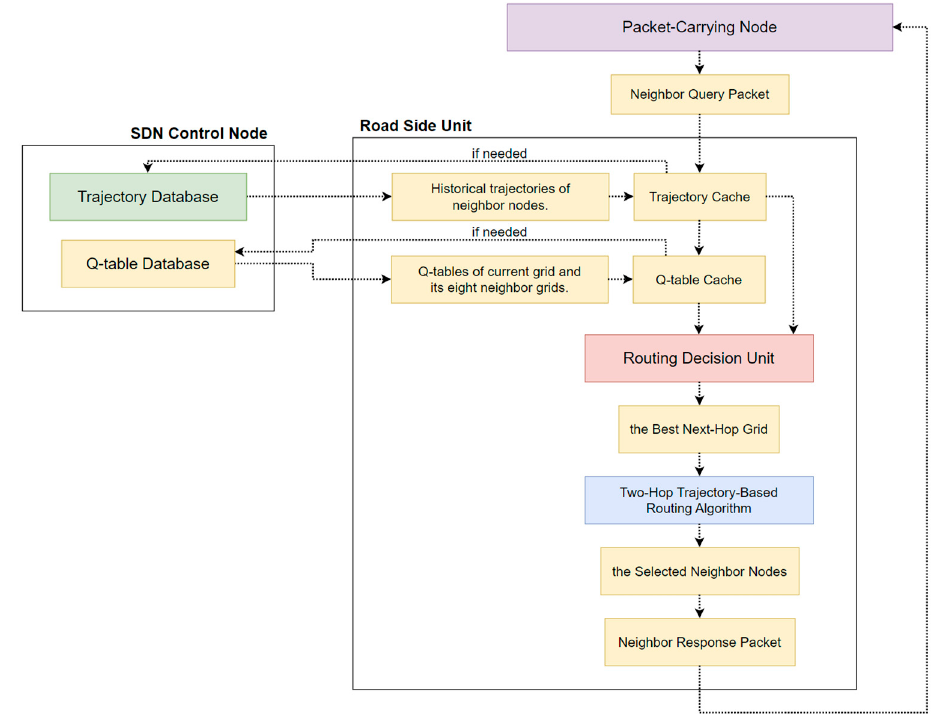
Figure 8. The online routing decision process of SD-QGrid.